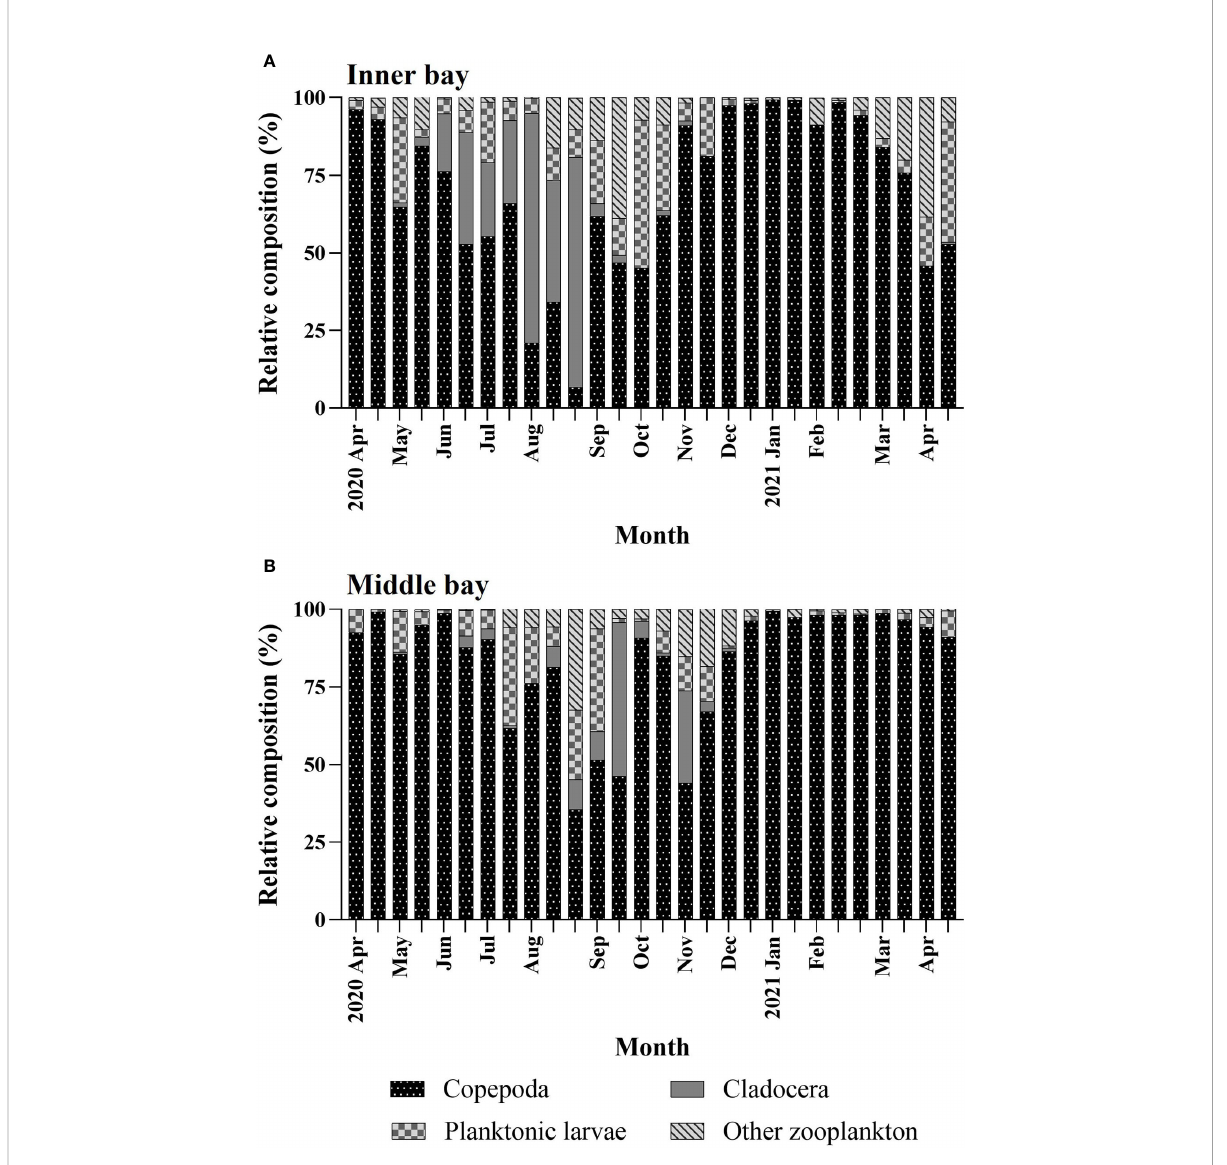
FIGURE 4 Temporal variations in percentages of mesozooplankton composition in the (A) inner bay and (B) middle bay in Gamak Bay from April 2020 to April